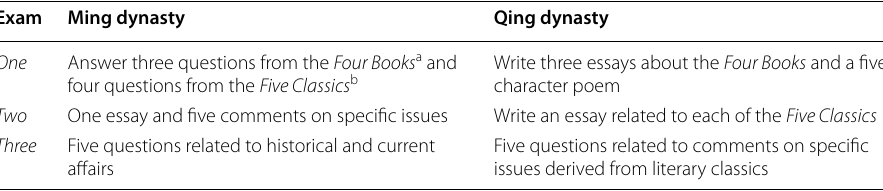
a The Great Learning, the Doctrine of the Mean, the Confucian Analects, and the Works of Mencius